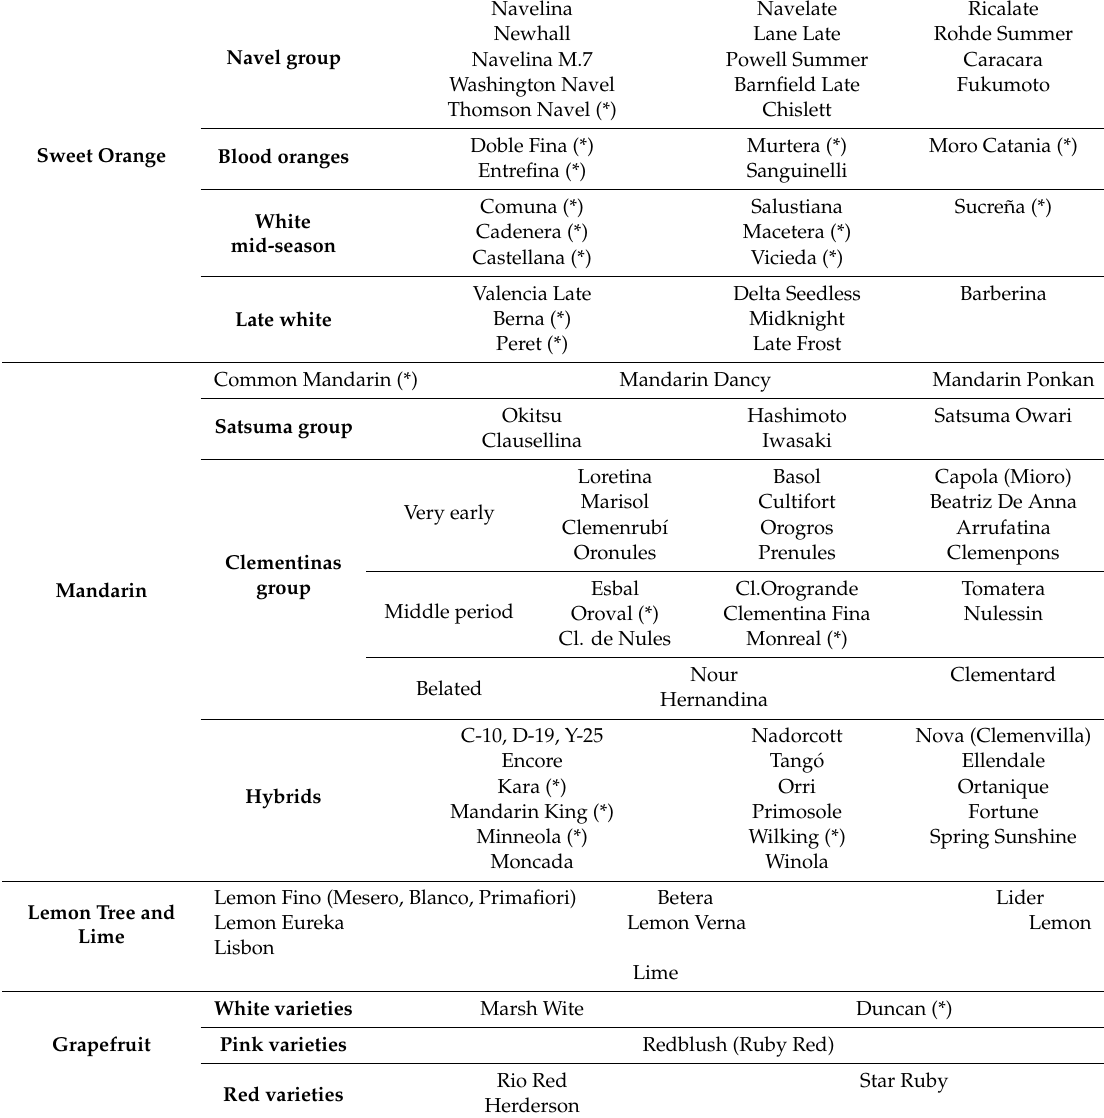
Table 3. Main Spanish citrus